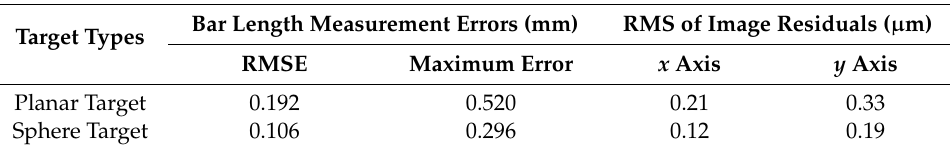
Table 6. Calibration accuracy under different target types.